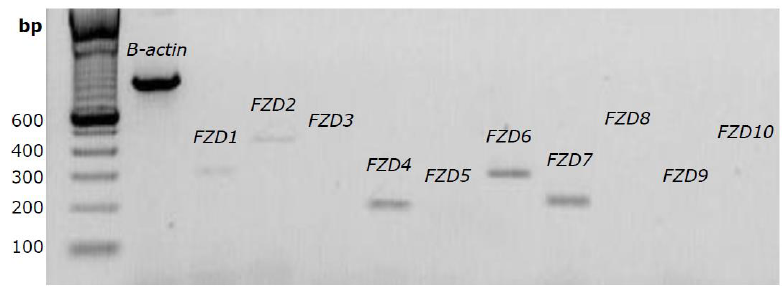
Figure 3. Several FZD receptors are expressed in human CASCs. Representative gel of FZD1 to FZD10 expression after 25 PCR cycles. β-actin was used as internal control.